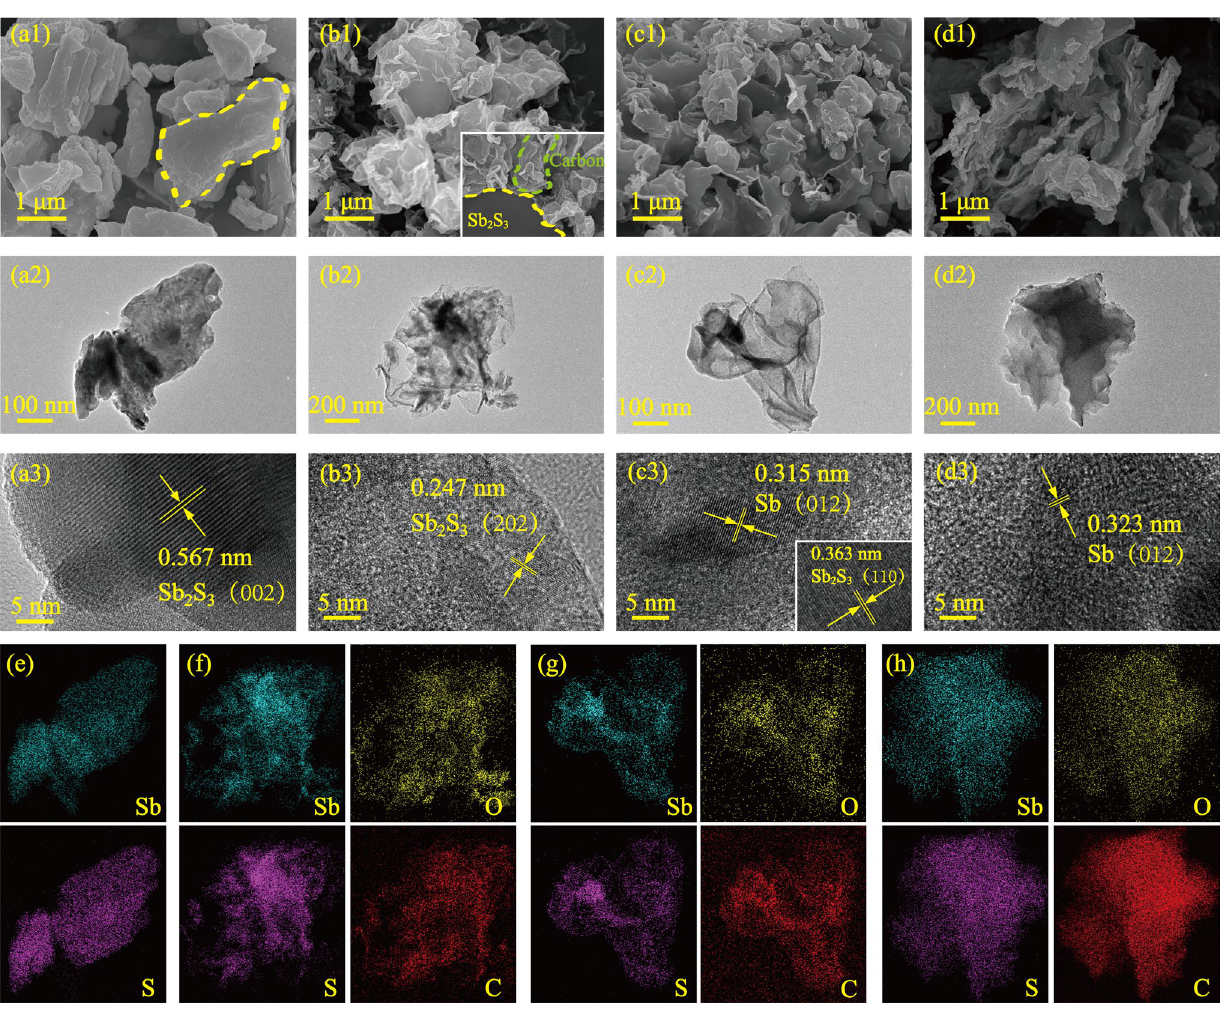
Fig. 2 SEM, TEM, and HRTEM images of ( a ) stibnite Sb 2 S 3 , b Sb 2 S 3 @0.1CDs, c Sb 2 S 3 @0.3CDs and ( d ) Sb 2 S 3 @0.5CDs. The corresponding EDX element mapping images of ( e ) Sb 2 S 3 , f Sb 2 S 3 @0.1CDs, g Sb 2 S 3 @0.3CDs, and ( h ) Sb 2 S 3